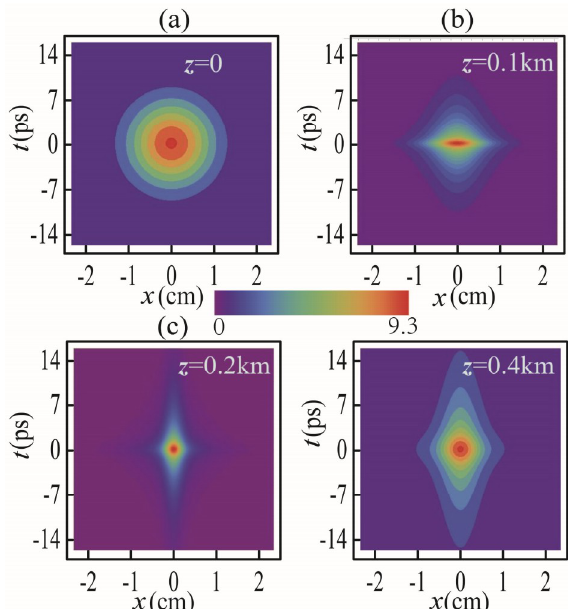
Figure 5. Contour graph of normalized spatial-temporal intensity distribution I ( x , t , z ) of PCP beams with rect weight function at z plane with different values of z : ( a ) z = 0, ( b ) z = 0.1 km, ( c ) z = 0.2 km and ( d ) z = 0.4 km in the x - t plane.